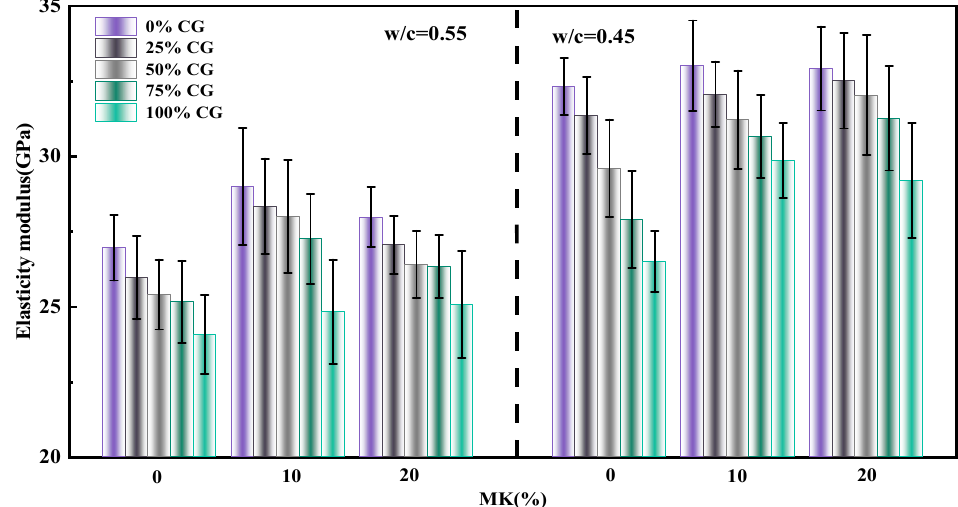
Figure 2. The elasticity modulus of the different concrete mixtures.